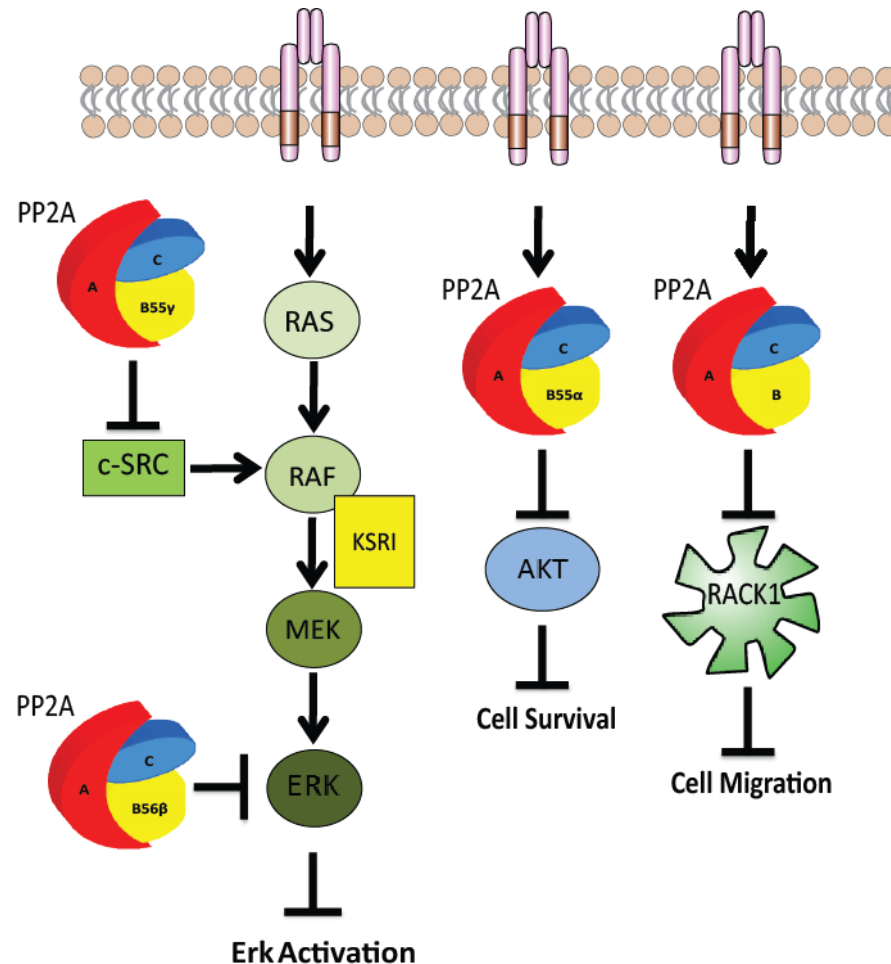
Figure 2. PP2A as a tumour suppressor in signaling pathways. The PP2A holoenzyme containing B55γ, negatively regulates the MAP kinase pathway through inhibition of c-SRC [3,69,70]. PP2A holoenzymes containing B56β and B56γ directly dephosphorylate ERK to negatively regulate the MAP kinase pathway [59]. PP2A negatively regulates Akt activity through dephosphorylation of Akt at Thr 308 to regulate cell survival [71]. As well as functioning as a phosphatase, PP2A also controls cell migration by acting as a regulator of growth factor and adhesion receptor assembly through its interaction with RACK1 during cell migration